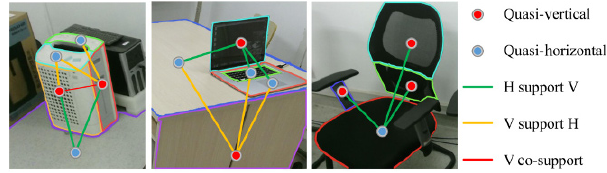
Fig. 7 Automatically detected support relations. Left: the quasi- vertical patches co-support the top quasi-horizontal